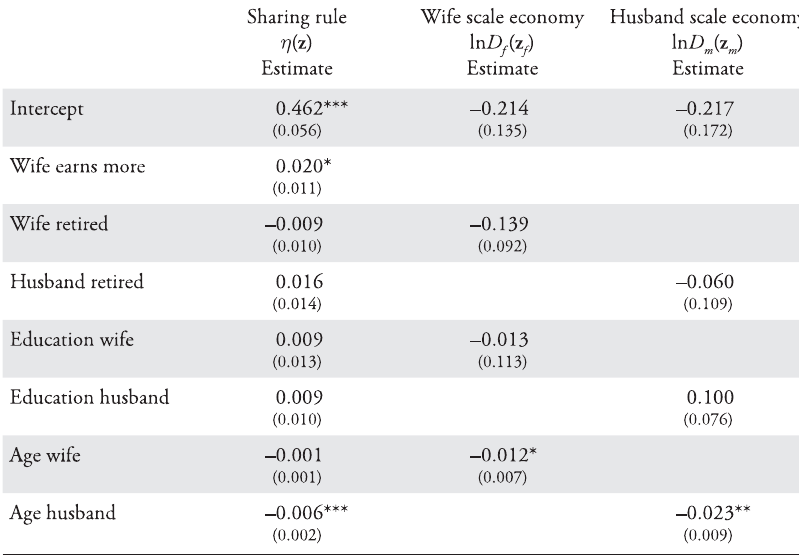
Table 4: Sharing Rule and Scale Eamomy Parameter